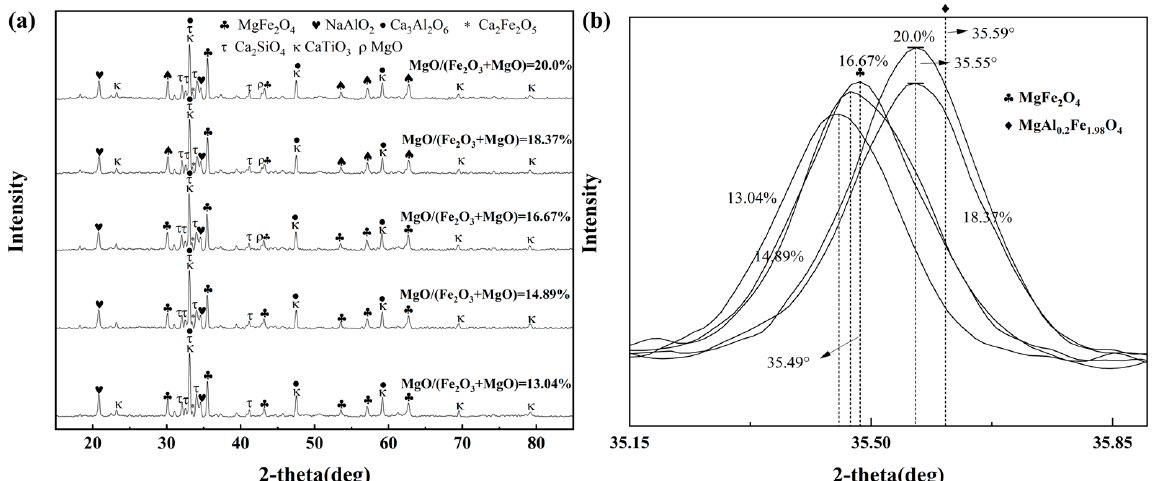
Figure 10. XRD pa tt erns of the sintered red mud with di ff erent MgO mass fractions ( a ) and magni- Figure 10. XRD patterns of the sintered red mud with different MgO mass fractions ( a ) and magnified fi ed image at the spinel di ff raction peak ( b ). image at the spinel diffraction peak ( b